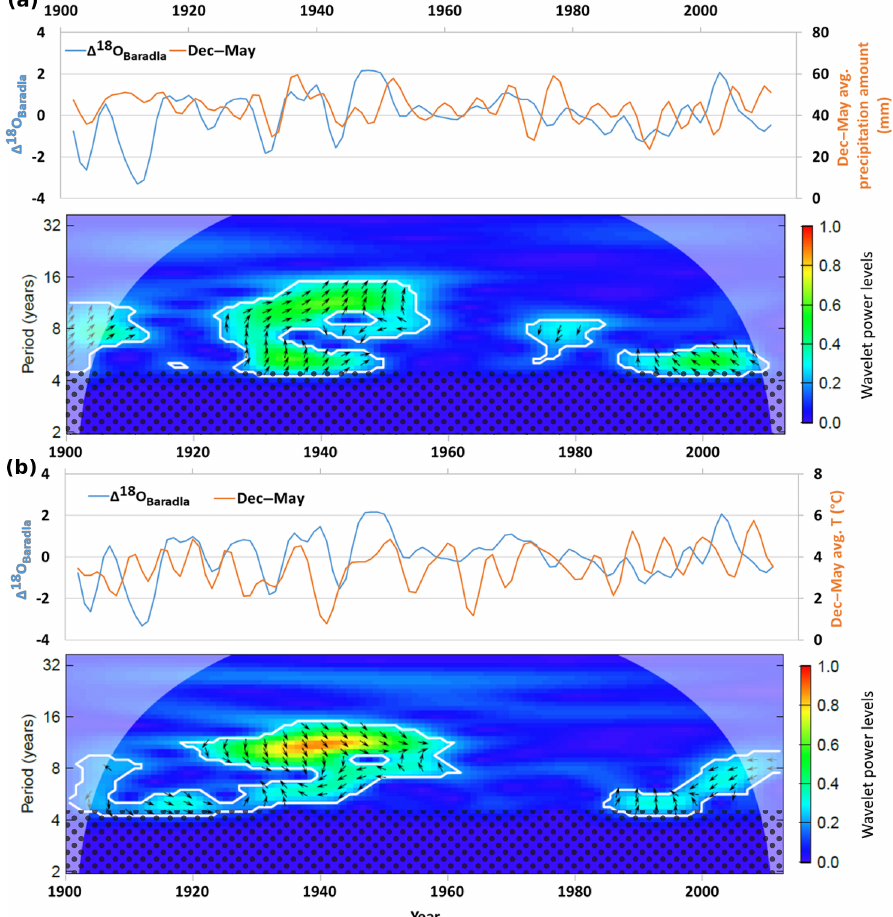
Figure 5. Time series of the 4.5-year low-passed composite (cid:49) 18 O records with the gridded climate data (Harris et al., 2014) December–May average (a) precipitation and (b) temperature (upper panels) and their time–frequency coherency image (lower panels). For further details see the caption of Fig.